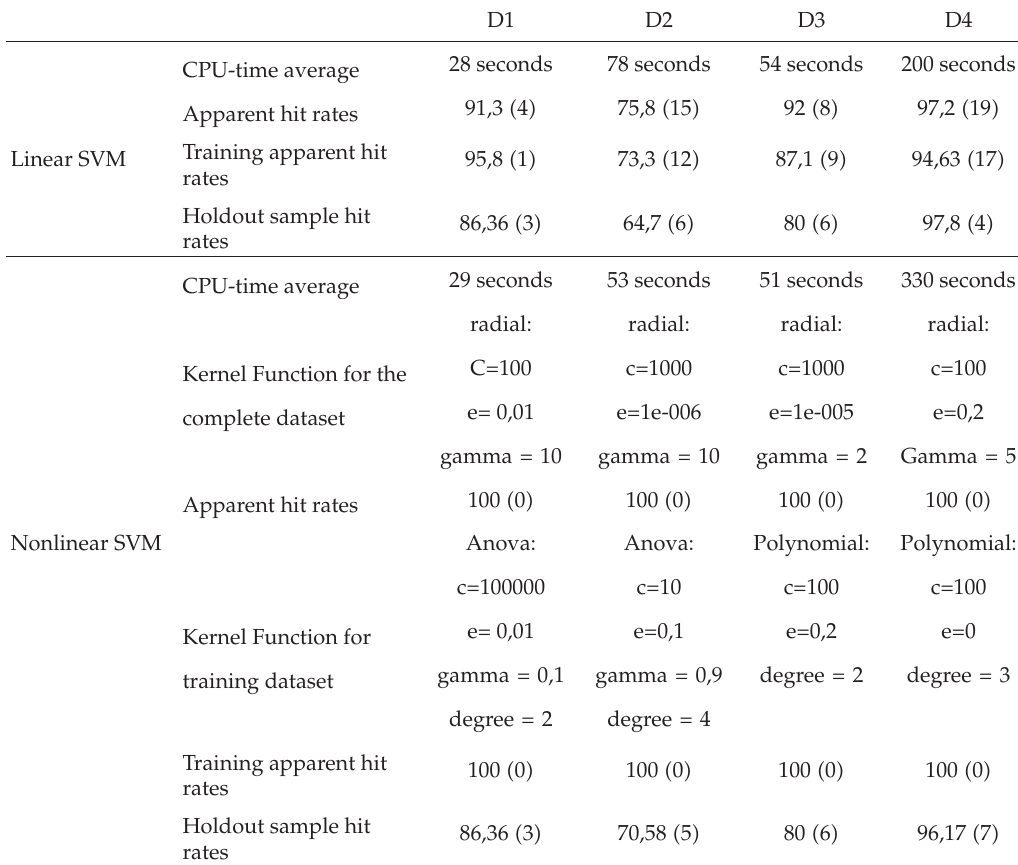
Table 11: The SVM-based approach